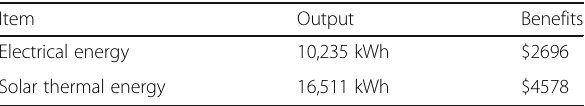
Table 2 Economical value of annual benefits of PVT system Item